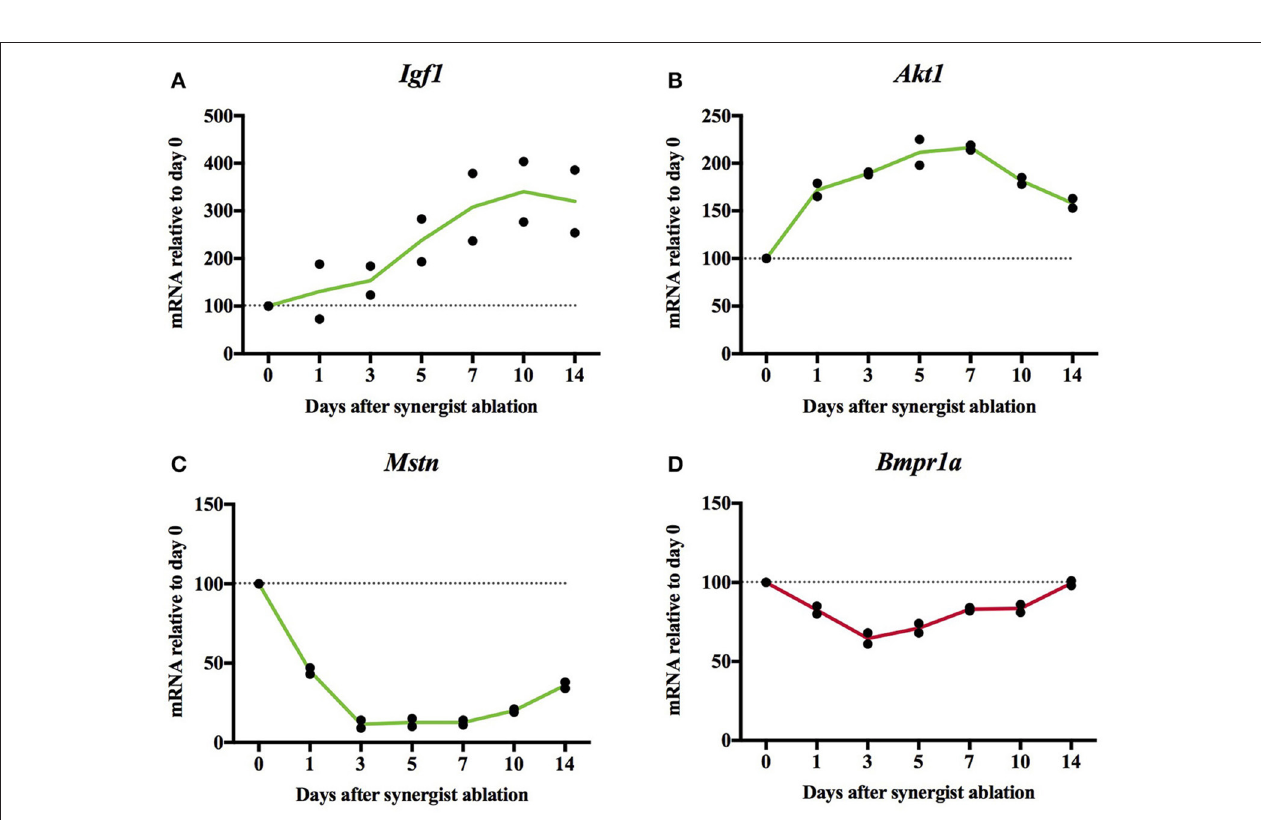
FIGURE 4 | Relative mRNA expression of Igf1 (A) , Akt1 (B) , Mstn (C) , and Bmpr1a (D) in synergist ablation-overloaded mouse plantaris muscle. Igf1, Akt1, Mstn change their expression which is consistent with the hypertrophy of the plantaris. In contrast, Bmpr1a did not change its expression as expected as the overexpression of Bmpr1a causes hypertrophy (Sartori et al., 2013) whilst its expression decreased in the hypertrophying plantaris (see Supplementary Table S3, worksheet 7 for further figures). Original data derived from microarray dataset GSE47098 data from Chaillou et al. (2013).